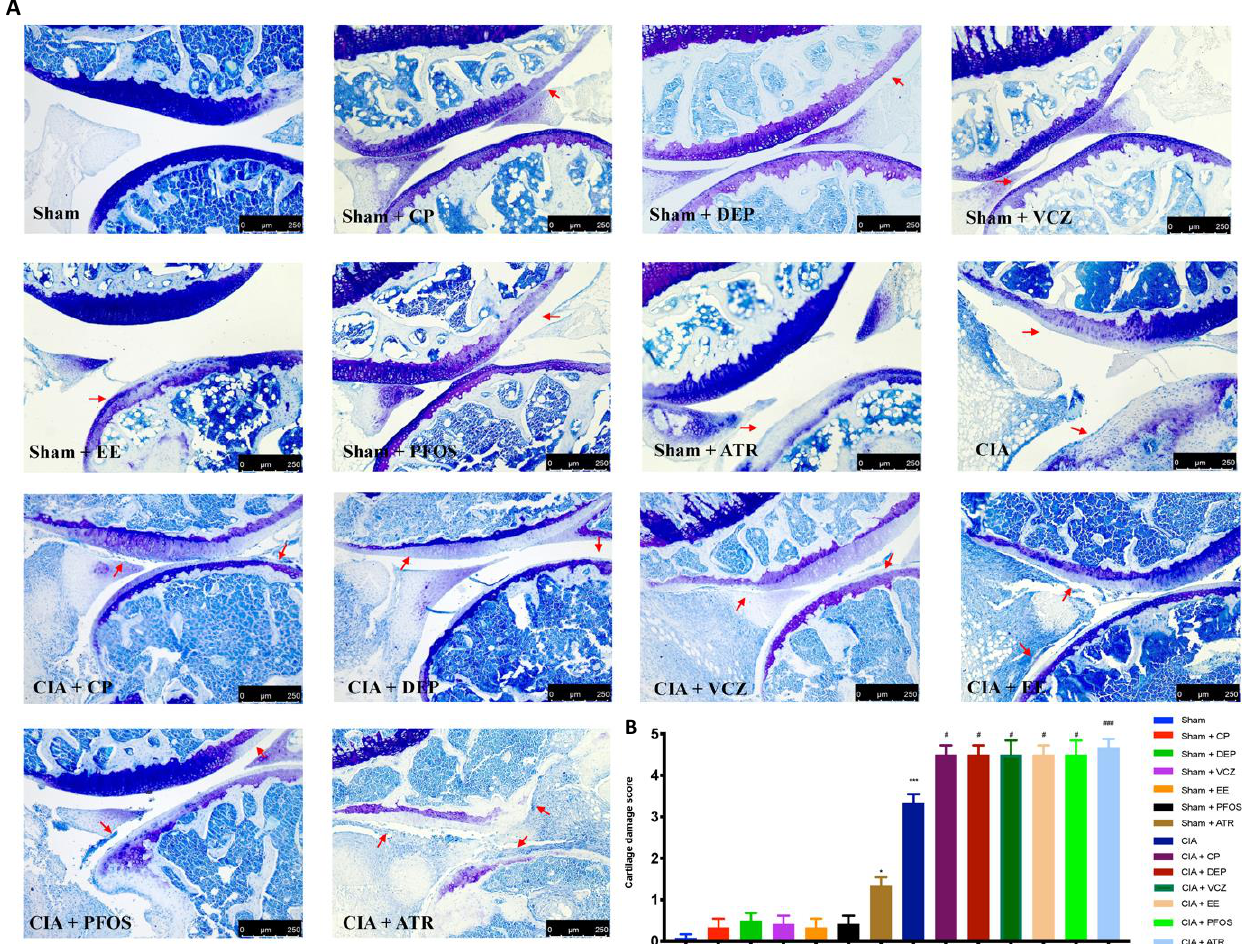
Figure 6. Toluidine blue staining for knee from all groups ( A ); cartilage damage score ( B ). A 10× magnification is shown (250 µm scale bar). Red arrows indicated cartilage damage. * p < 0.05 vs. sham; *** p < 0.001 vs. sham; # p < 0.05 vs. CIA; ### p < 0.001 vs. CIA.